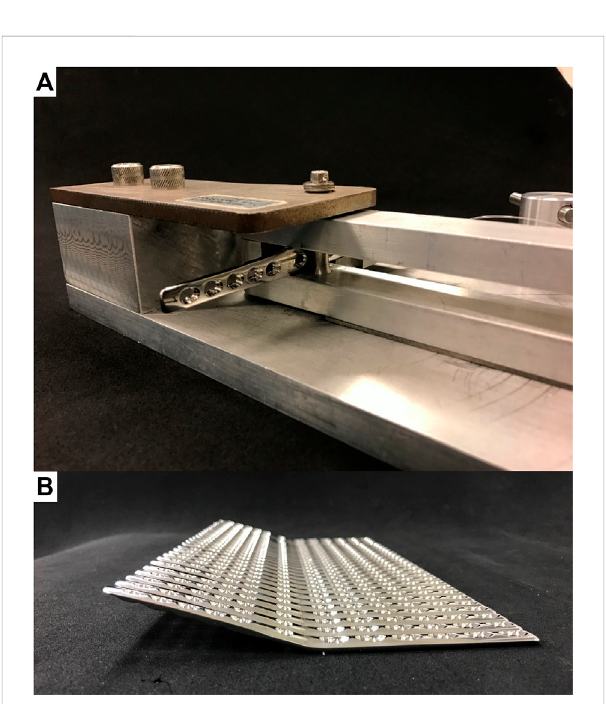
FIGURE 2 Pre-bending of round-hole PCA plates to 20 ° joint fusion angle; (A) Photograph showing a plate fi xed within the bending press; (B) A consistent bending angle of all plates was